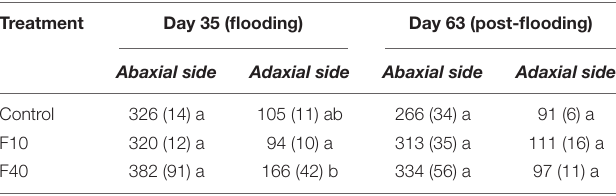
TABLE 1 | Stomatal density (stomata per mm − 2 ) in fully expanded willow leaves during flooding (Day 35) and post-flooding periods (Day 63). Treatment